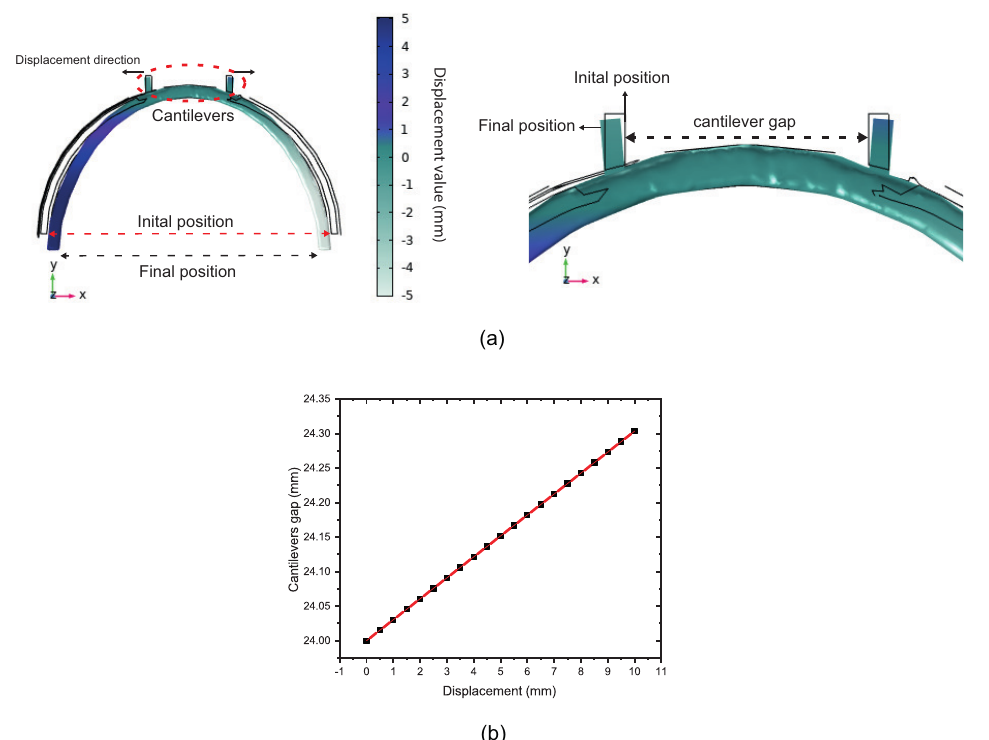
Figure 4. Static structural analysis of the piece with cantilevers based on FEM. ( a ) Schematic of the mechanism to increase the cantilevers gap in the 3D piece. ( b ) The linear relationship between cantilevers gap and displacement applied in the 3D piece.